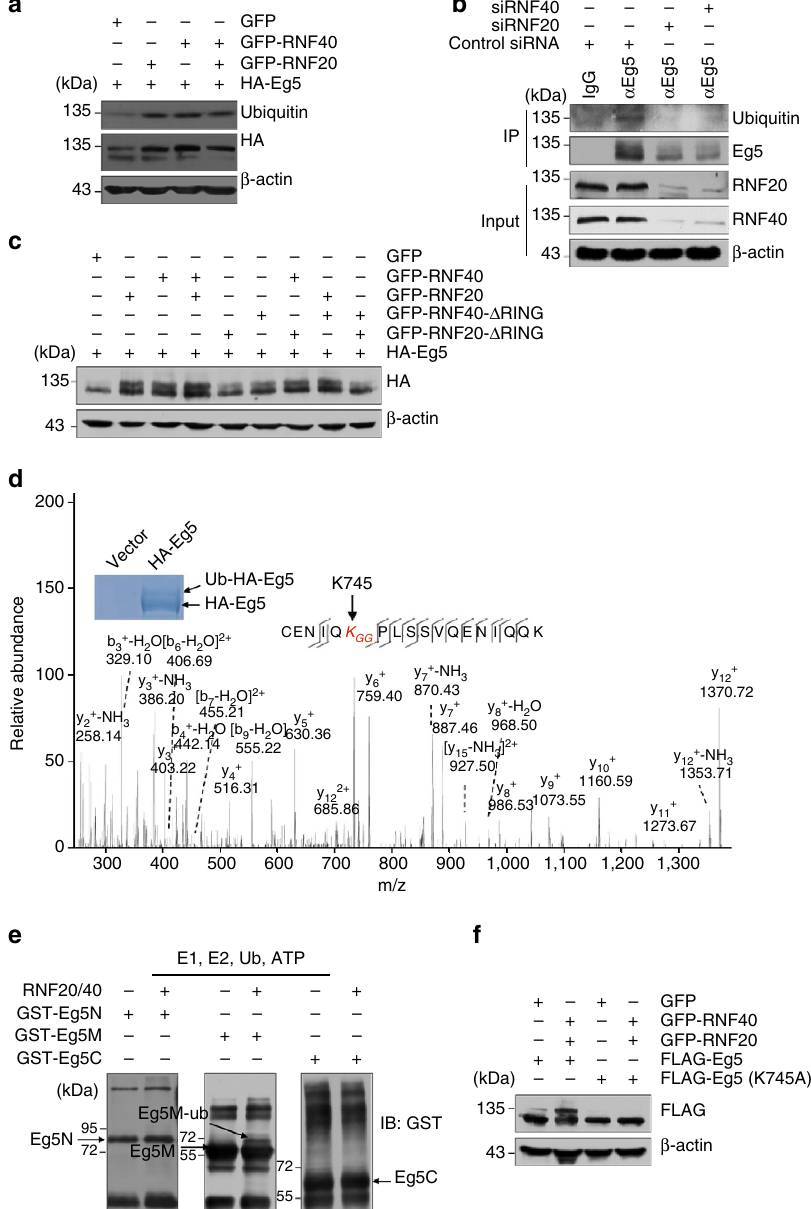
Figure 3 | The RNF20/40 complex catalyses the monoubiquitination of Eg5 at lysine 745. ( a ) Overexpression of the RNF20/40 complex increased the monoubiquitination of Eg5. GFP-RNF20 or/and GFP-RNF40 expression constructs were transfected into MCF-7 cells together with HA-Eg5 and Myc-Ubiquitin expression constructs. Immunoprecipitation assays were performed with antibodies against HA, followed by immunoblotting with antibodies against HA and ubiquitin. ( b ) RNF20/40 is essential for the monoubiquitination of endogenous Eg5. Cell lysates from MCF-7 cells transfected with control or RNF20/40 siRNAs were subjected to immunoprecipitation with anti-Eg5 followed by immunoblotting with anti-ubiquitin and anti-Eg5. ( c ) The RING-finger domain of the RNF20/40 complex is essential for catalysing the monoubiquitination of Eg5. MCF-7 cells were co-transfected with the indicated expression constructs and HA-Eg5. Cell lysates were subjected to western blotting with antibodies against the indicated proteins. ( d ) Identification of lysine residue monoubiquitinated in Eg5. Cellular extracts from MCF-7 cells expressing HA-Eg5 were immunopurified with anti-HA affinity columns and eluted with HA peptides. The eluates were resolved by SDS–PAGE and coomassie blue-stained. The protein band indicating Ub-HA-Eg5 on the gel were retrieved and analysed by LCMS/MS. ( e ) Monoubiquitination of Eg5 by the RNF20/40 complex in vitro . Recombinant GST-Eg5N, GST-Eg5M or GST-Eg5C was incubated in the presence of E1, E2, Ub and ATP with or without the RNF20/40 complex purified from Sf9 cells, followed by western blotting using antibodies against GST. ( f ) Eg5 is monoubiquitinated at K745 by the RNF20/40 complex. GFP-RNF20 and GFP-RNF40 expression constructs were co-transfected with FLAG-Eg5 or FLAG-Eg5K745A into MCF-7 cells. Cell lysates were subjected to western blotting with antibodies against the indicated